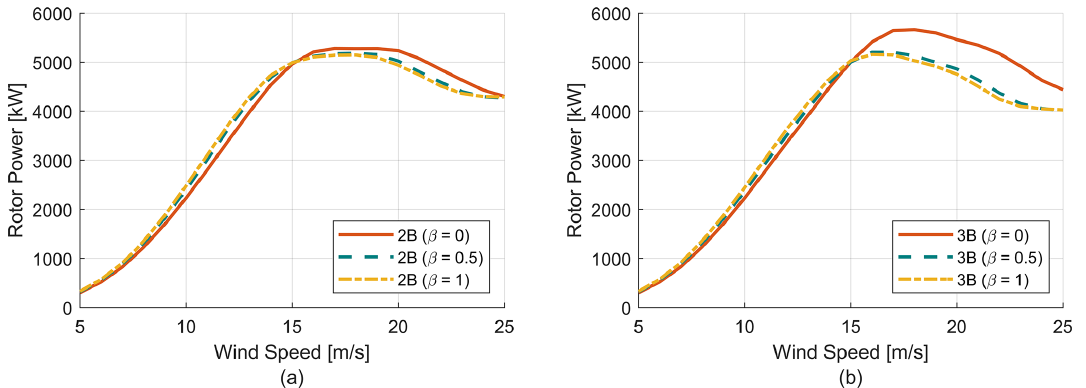
Figure 7. Rotor power performance analysis. (a) Power vs. wind speed curve for two-bladed (2B) rotors. (b) Power vs. wind speed curve for three-bladed (3B)